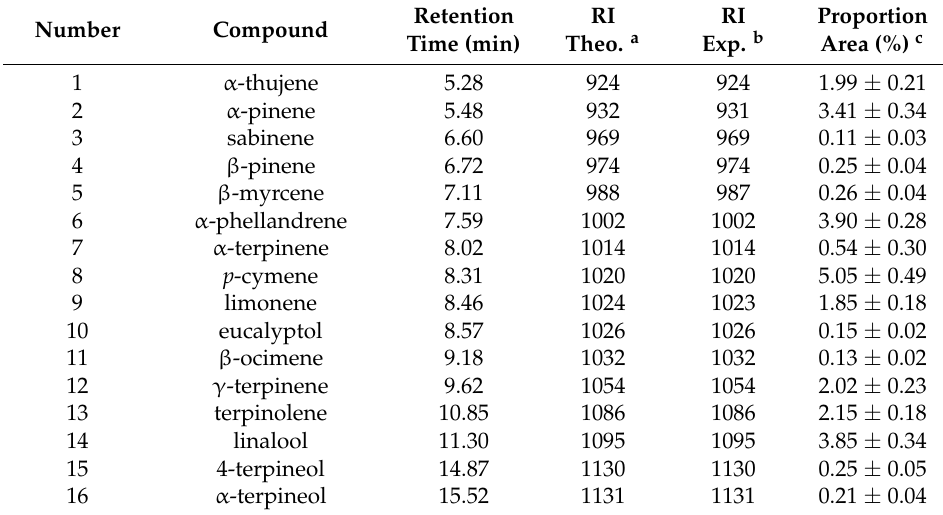
Table 1. Chemical composition of the essential oil from the leaves of Croton